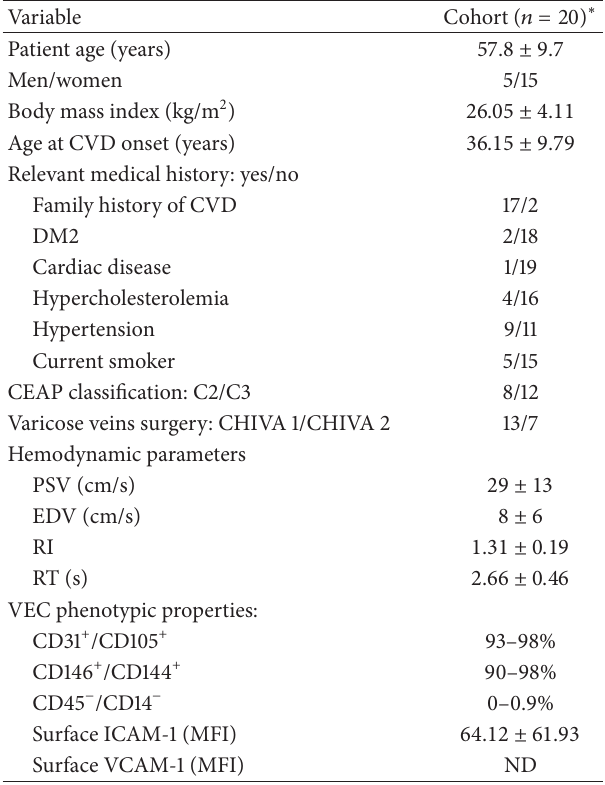
Table 1: Main demographic and clinical data of the cohort of patients and phenotypic characteristics of the purified